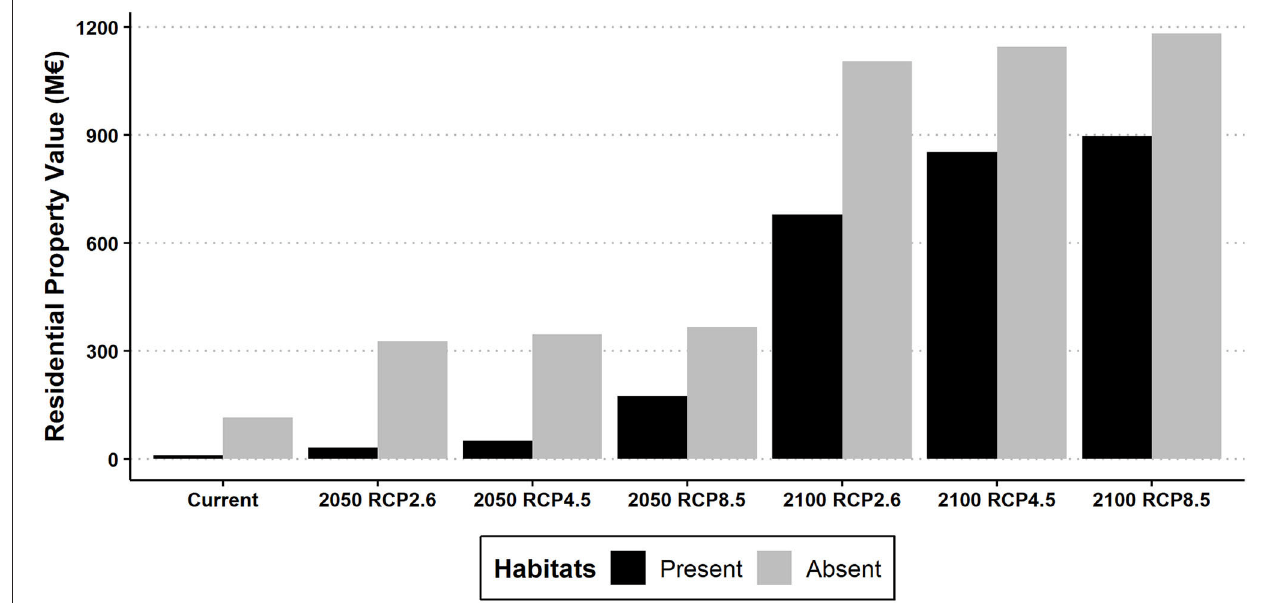
FIGURE 7 | Total potential residential property damage value (2017 value in millions of Euros–M e ) in areas with High and Very High Exposure Index values under each RCP and habitat scenarios for the years 2050 and 2100 in the northern coast of Portugal. RCP, Representative Concentration